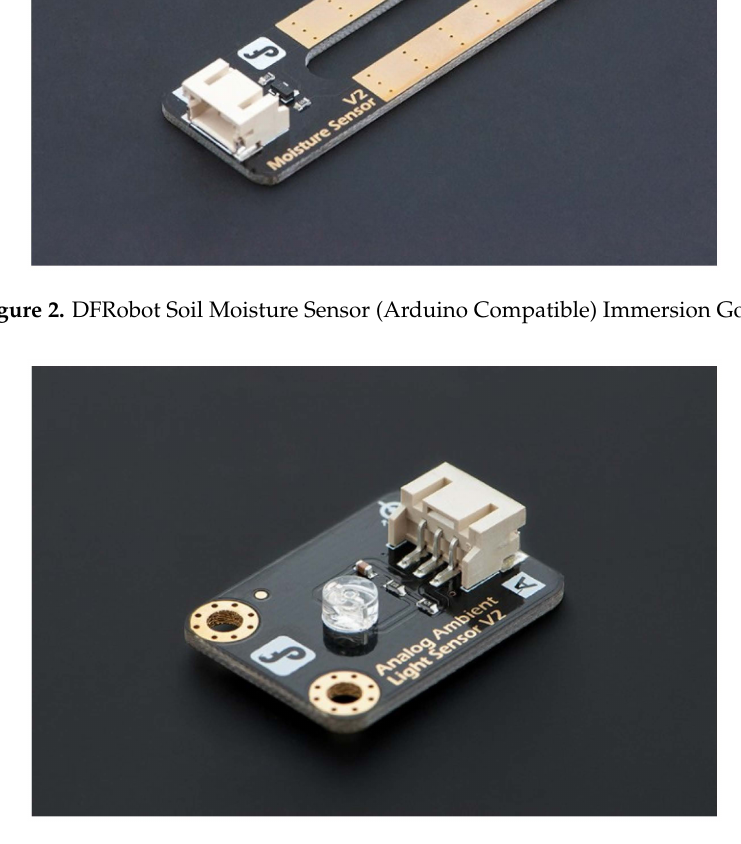
Figure 3. DFRobot Analog Ambient Light Sensor.